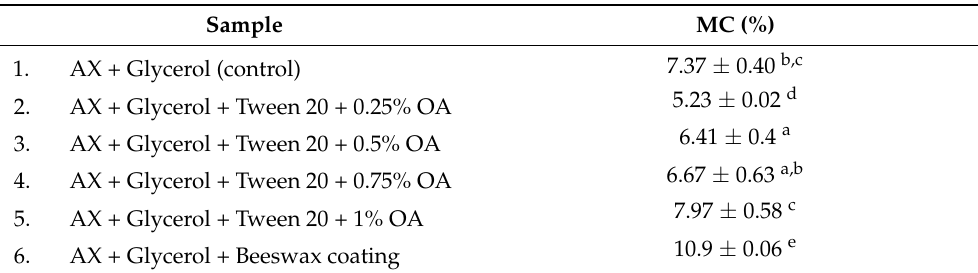
Table 8. Moisture content (MC, %) of all the film samples. Values in the same column followed by different superscript letters differ significantly ( p <